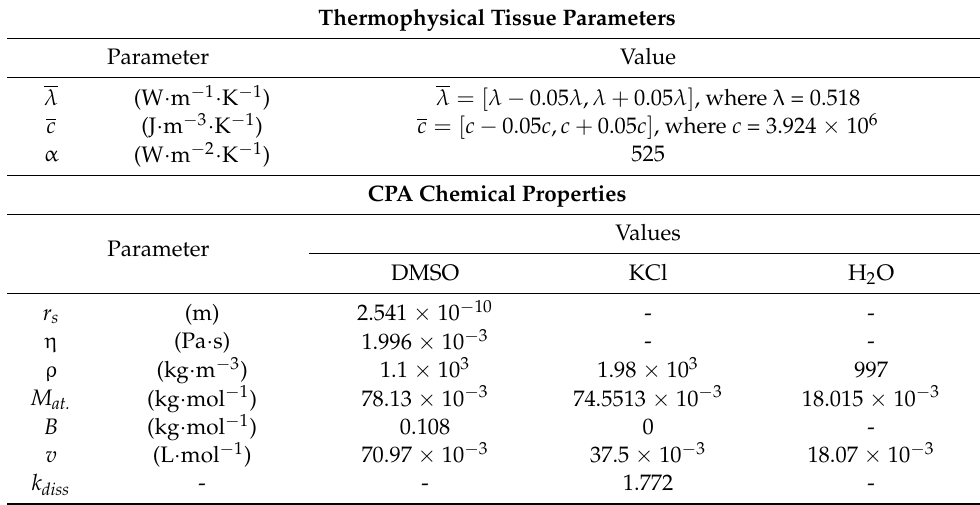
Table 1. Thermophysical parameters of the tissue and chemical properties of the CPA [13,41,45]. Thermophysical Tissue